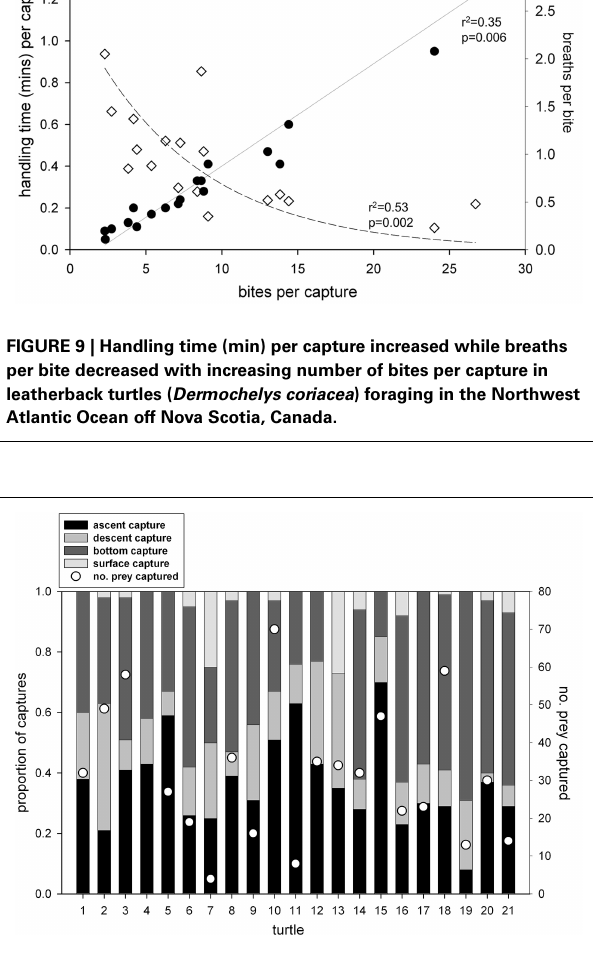
FIGURE 10 | Proportion of prey captures within different segments of leatherback turtle ( Dermochelys coriacea ) dive profiles (number of captures also included for reference). Statistically significant differences among proportions of captures by dive segments were as follows: bottom, ascents > descents > surface intervals [ F (87) = 29 . 0, p < 0 . 0001] (See Table 3